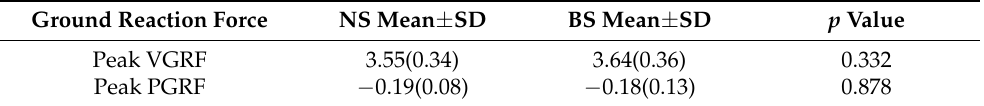
Table 3. Comparison of all kinetic variables between NS and BS during the SLL phase when jumping from 40 cm